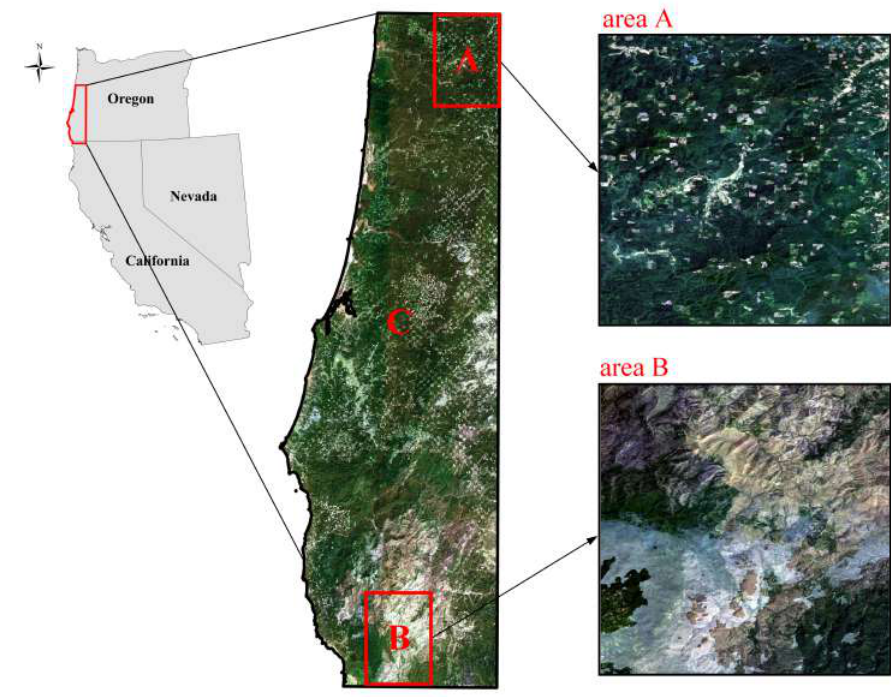
Figure 1. Study on west coast area of USA. Area A is dominated by forest decline, while Area B is dominated by